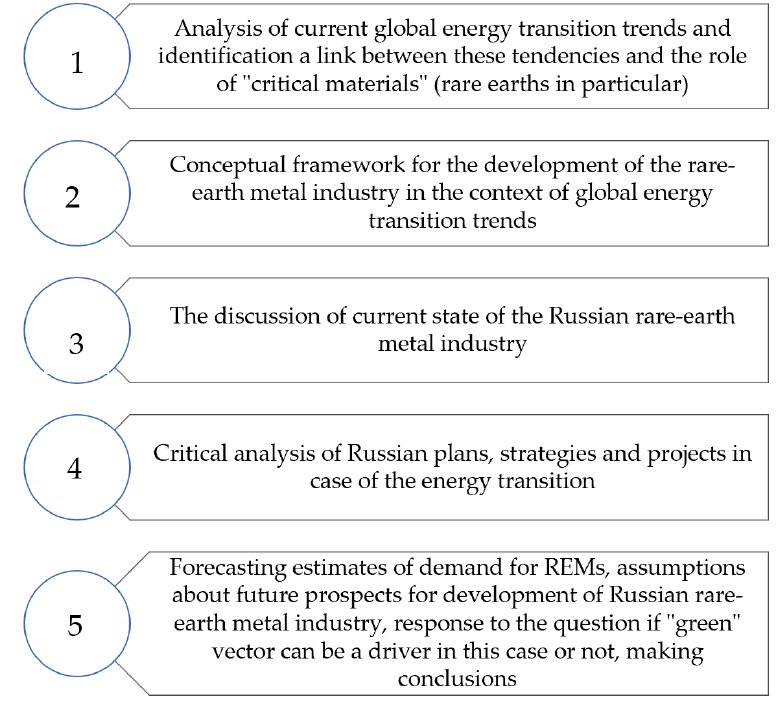
Figure 1. Algorithm of the research.